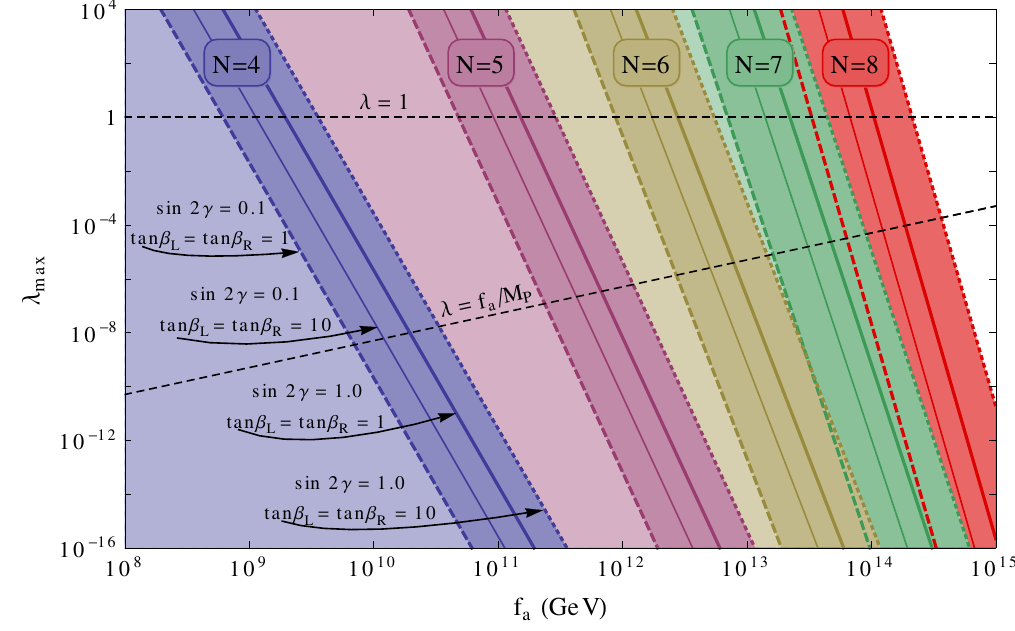
Figure 2 . Maximum values of (cid:21) 1 (cid:21) 2 consistent with eq. (2.22) for given values of f a and (cid:25) N = 4 ; 5 ; 6 ; 7 ; 8. The region to the left of each line indicates the axion models which return (cid:12) (cid:22) (cid:18) (cid:12) (cid:12) (cid:12) < 10 (cid:0) 11 without any (cid:12)ne tuning. From left to right within each band of a given N , models are indicated with: sin 2 (cid:13) = 0 : 1, tan (cid:12) L = tan (cid:12) R = 1 (thin, dashed); sin 2 (cid:13) = 0 : 1, tan (cid:12) L = tan (cid:12) R = 10 (thin, solid); sin 2 (cid:13) = tan (cid:12) L = tan (cid:12) L = 1 (thick, solid); and sin 2 (cid:13) = 1, tan (cid:12) L = tan (cid:12) L =